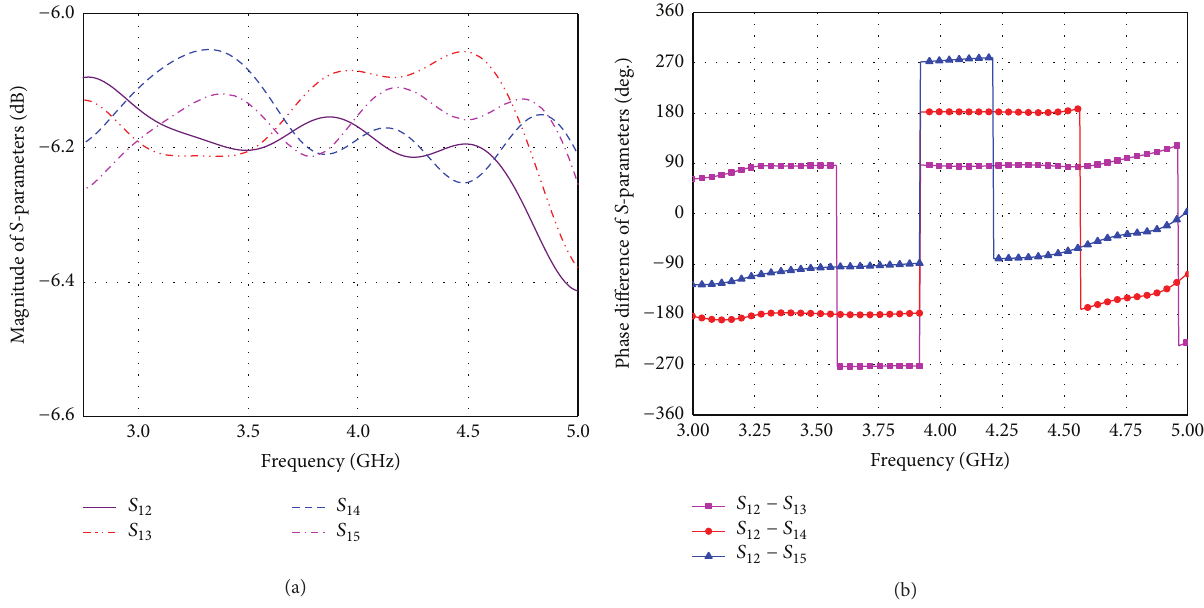
Figure 6: Simulated 𝑆 -parameters of the designed feed network. (a) Magnitude and (b) phase difference.